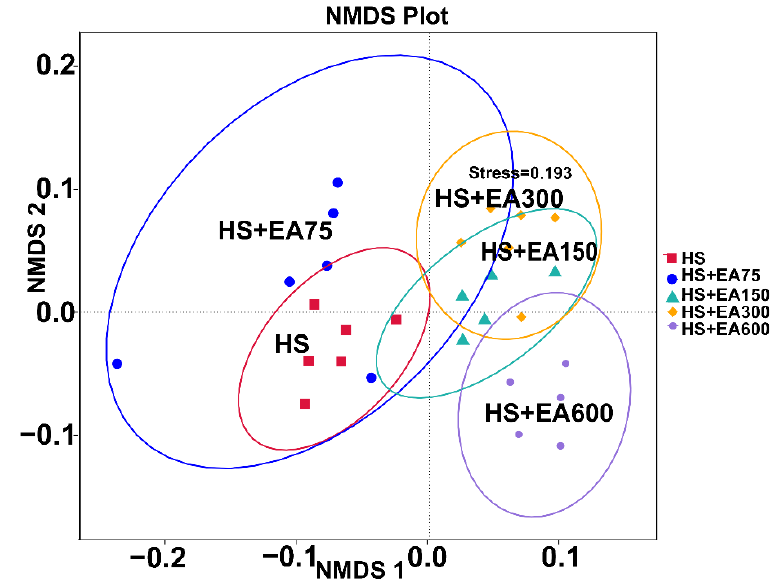
Figure 8. Two-dimensional nonparametric multidimensional scaling (NMDS) ordination plots of cecum microbial communities based on Bray–Curtis distance metric data of comparisons between groups. The broilers in the 5 experimental groups were supplemented with basal diets containing different levels of EA (0, 75, 150, 300, and 600 mg/kg) at HS temperature (35 ± 2 °C), which are represented as HS, HS + EA75, HS + EA150, HS + EA300, and HS + EA600, respectively. Ellipses indicate the standard deviations (SD). Red box represents HS group; blue circle represents HS + EA75 group; green triangle represents HS + EA150 group; yellow diamond represents HS + EA300 group; and purple circle represents HS + EA600 group.